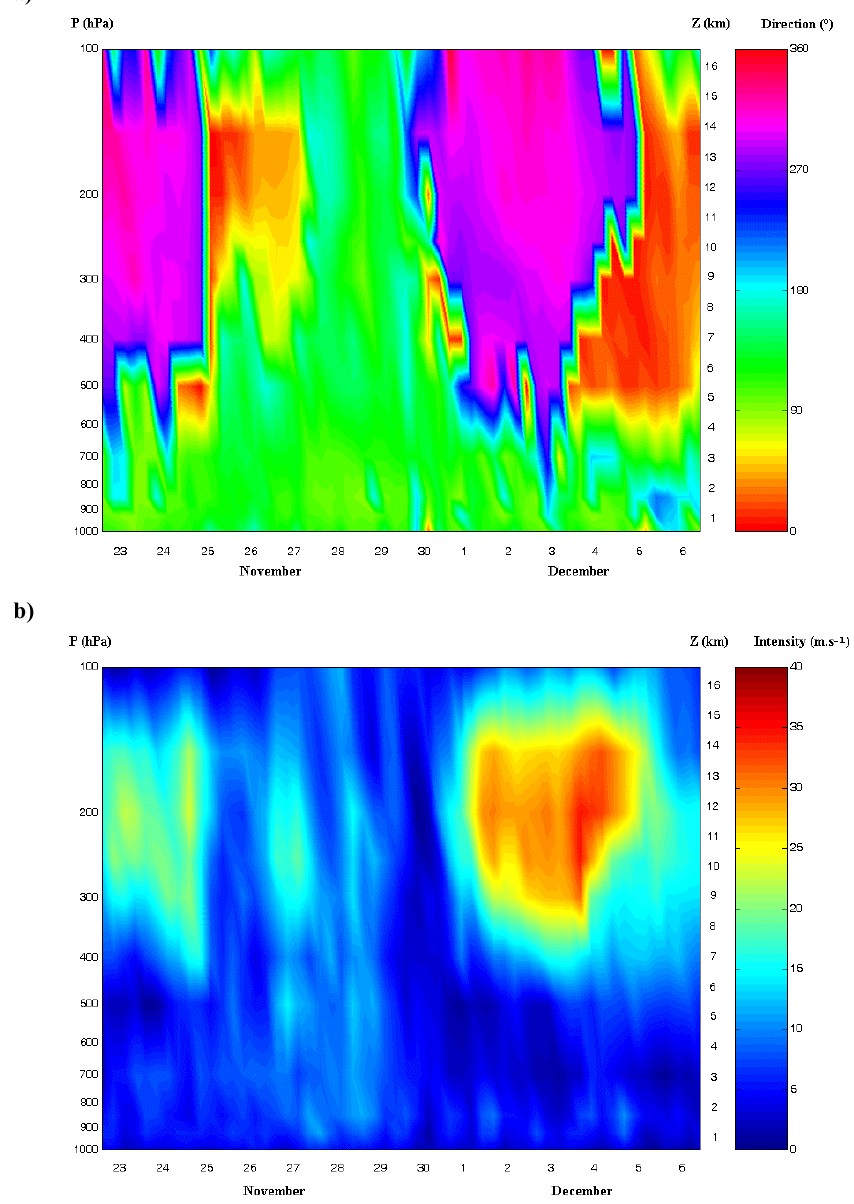
Fig. 3. ( a ) Horizontal wind direction (in degrees), and ( b ) intensity (in m.s − 1 ) over Reunion Island from 23 November to 6 December 1999. Figure 3 The direction 0 ◦ means a wind direction toward east, 90 ◦ toward north, 180 ◦ toward west and 270 ◦ toward south. The figure has been built from ECMWF with every 6h